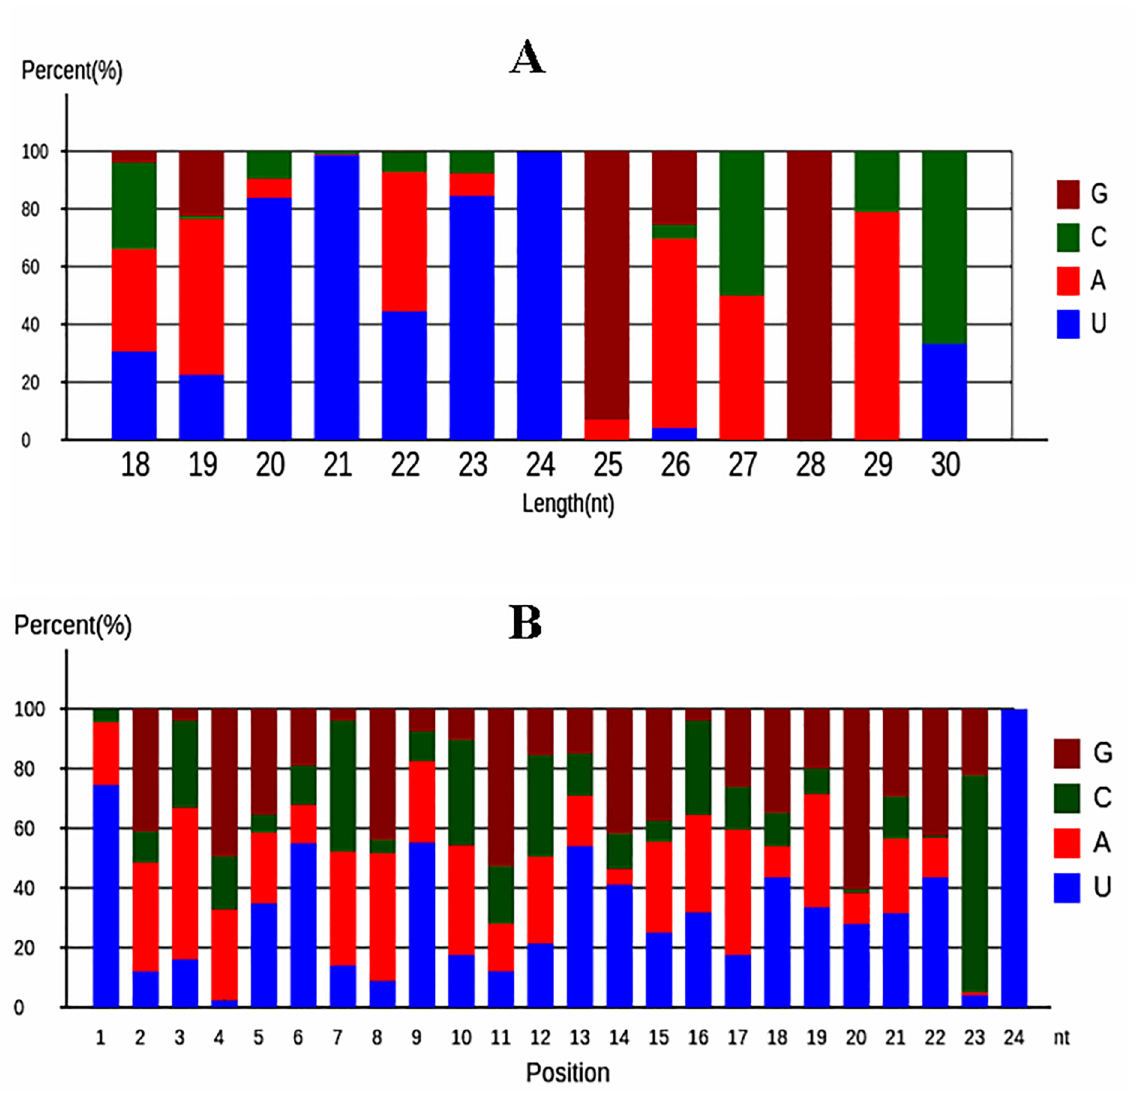
Fig 2. First nucleotide bias (A) and position nucleotide bias (B) analysis for miRNAs.